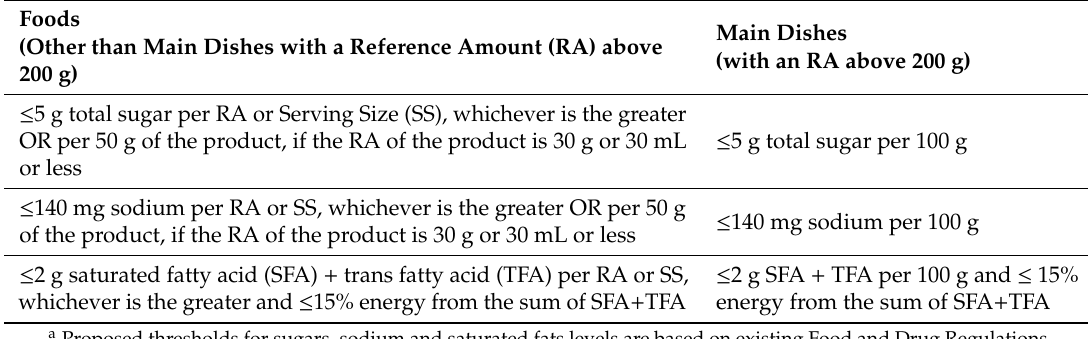
Table 1. Summary of proposed “low in” thresholds for sugars, sodium and saturated fats a,b .